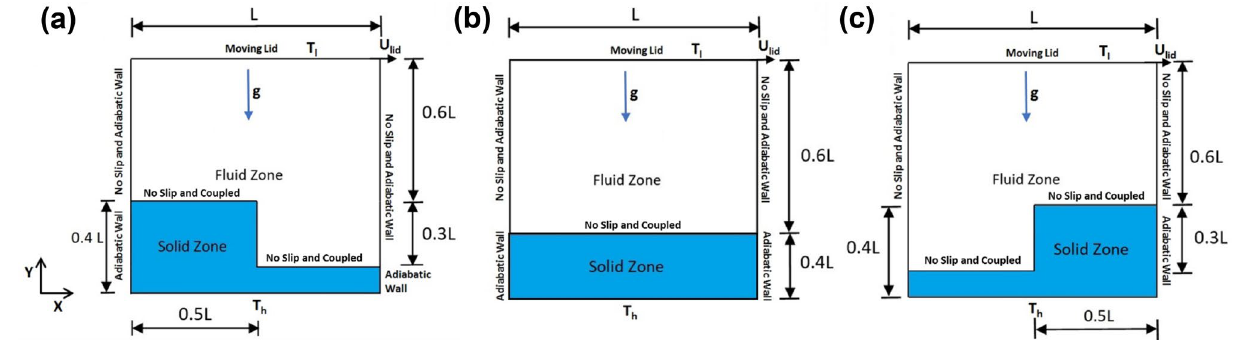
Fig. 1 Schematic representation of the cavity in three geometrical configurations: a Forward step, b No step and c Backward